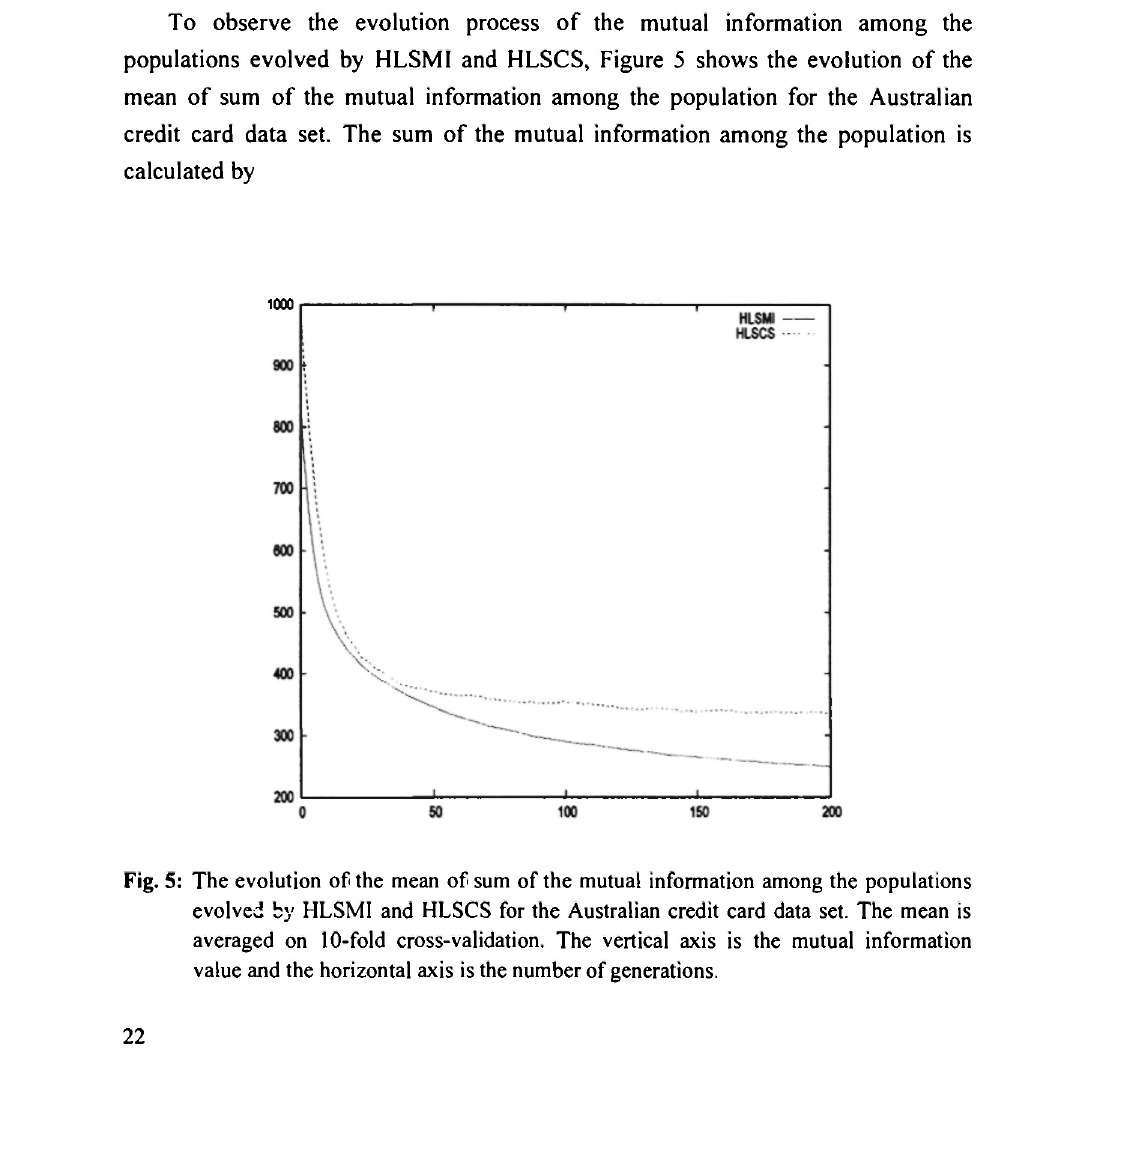
Fig. 5: The evolution of the mean of sum of the mutual information among the populations evolved by HLSMI and HLSCS for the Australian credit card data set. The mean is averaged on 10-fold cross-validation. The vertical axis is the mutual information value and the horizontal axis is the number of